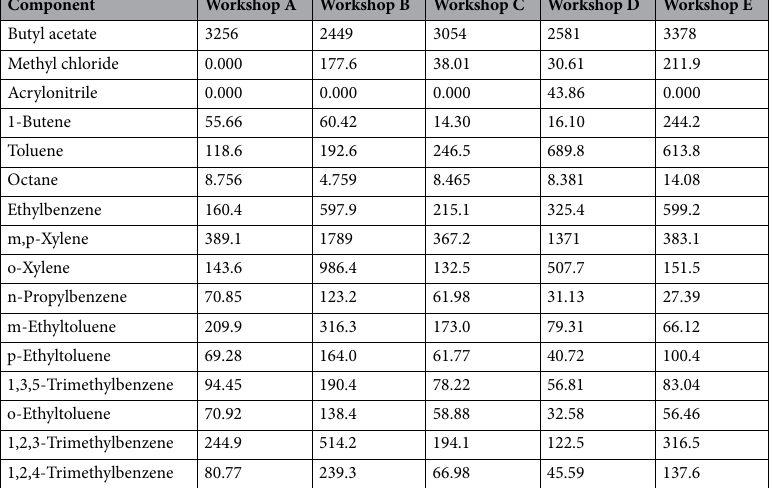
Table 1. Concentrations of the measured volatile organic compound (VOC) species in different workshops of auto-repair painting (unit: